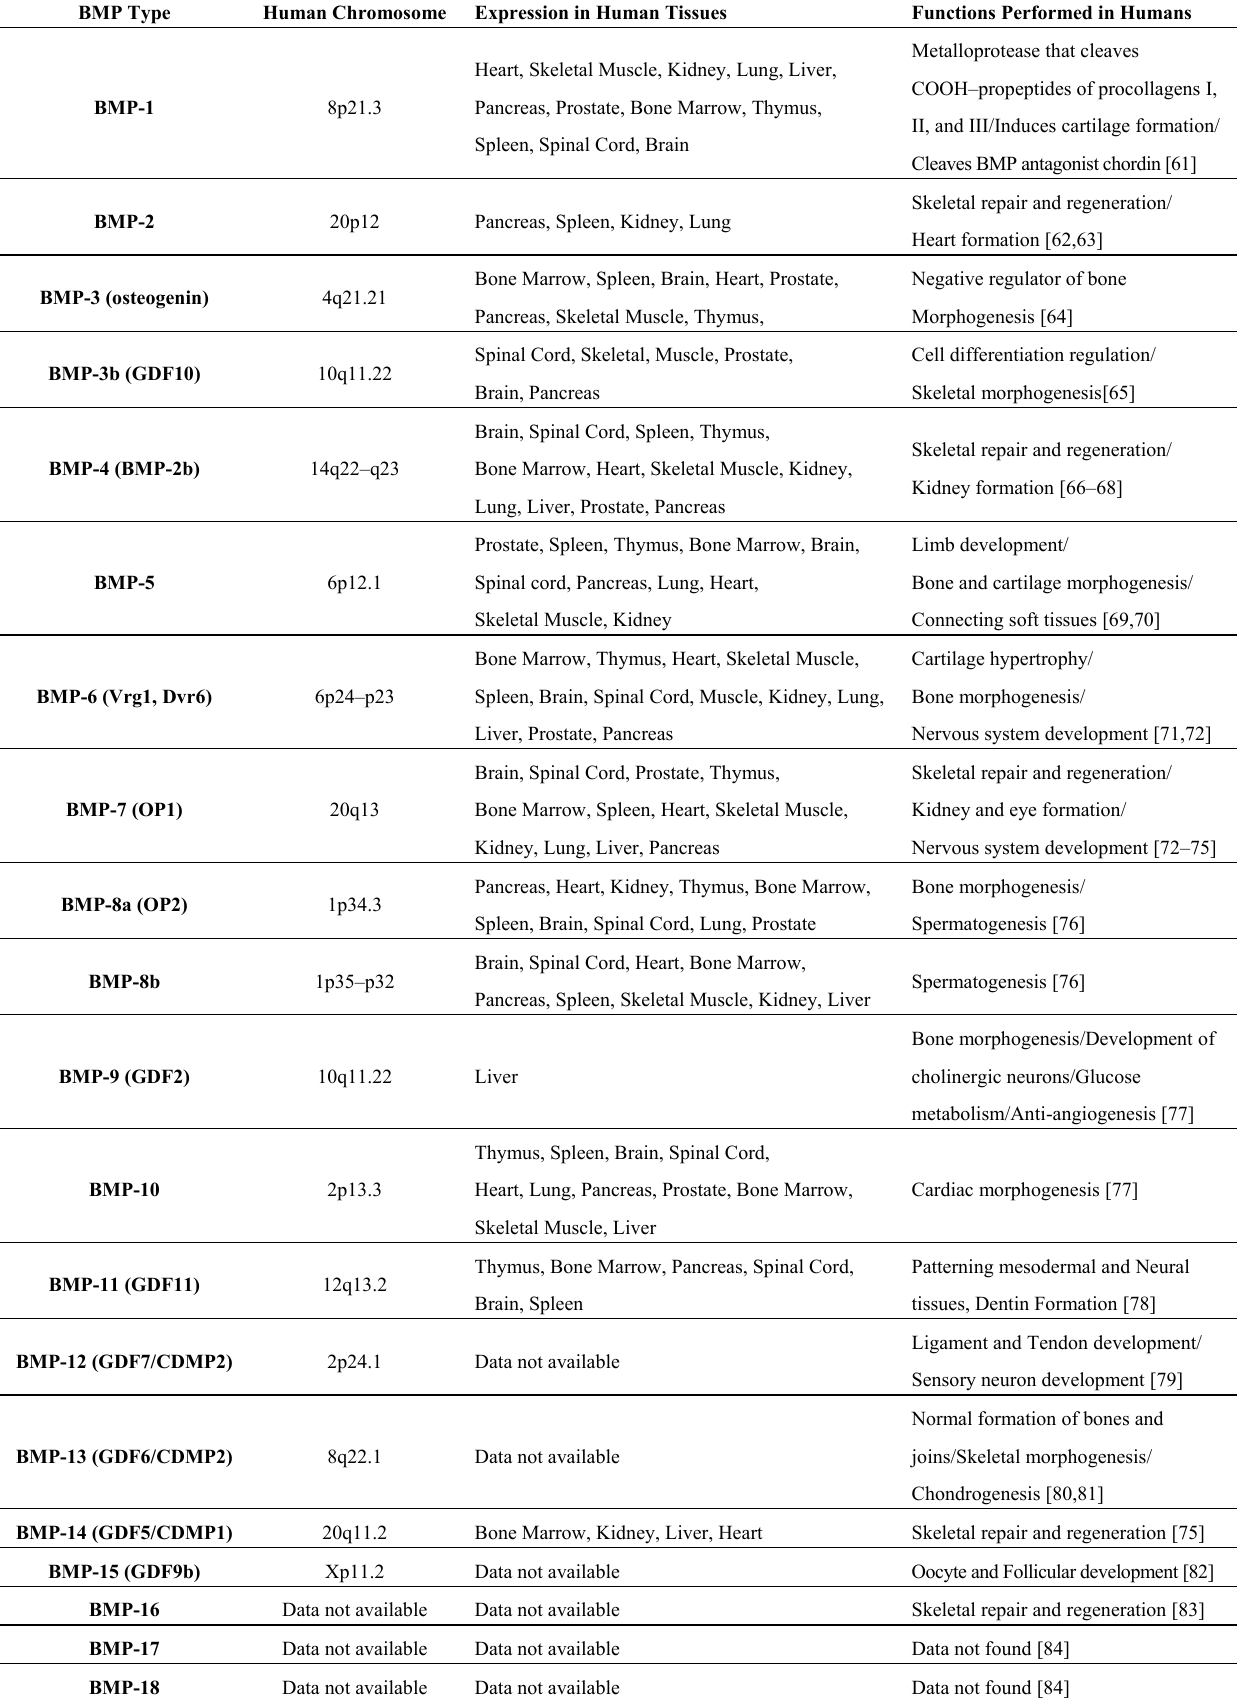
Table 1. Types, organs of expression and functions of